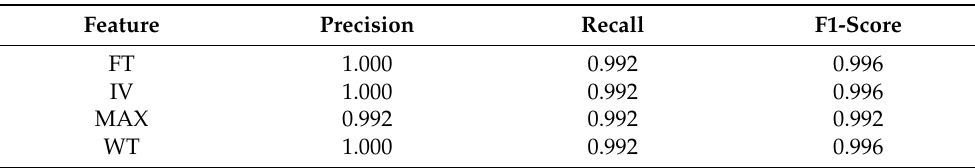
Table 5. Classification of non-existent exhalation after drinking by the RF classification model of each